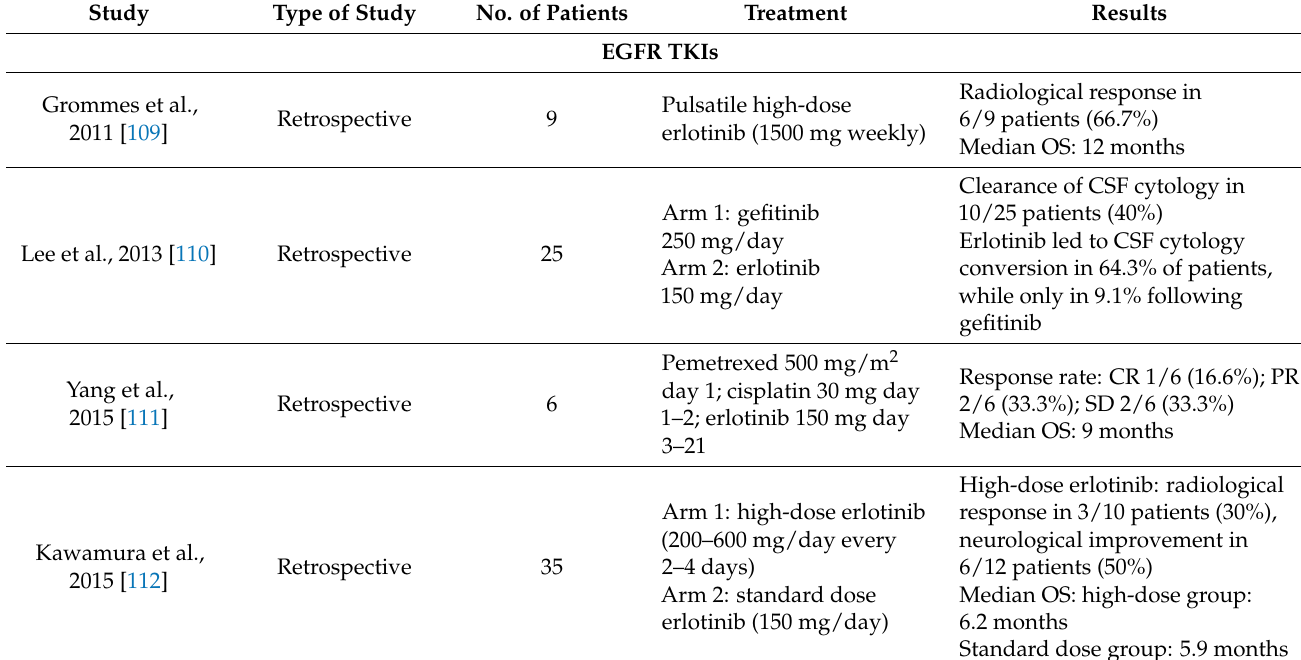
Table 4. Studies on LM from